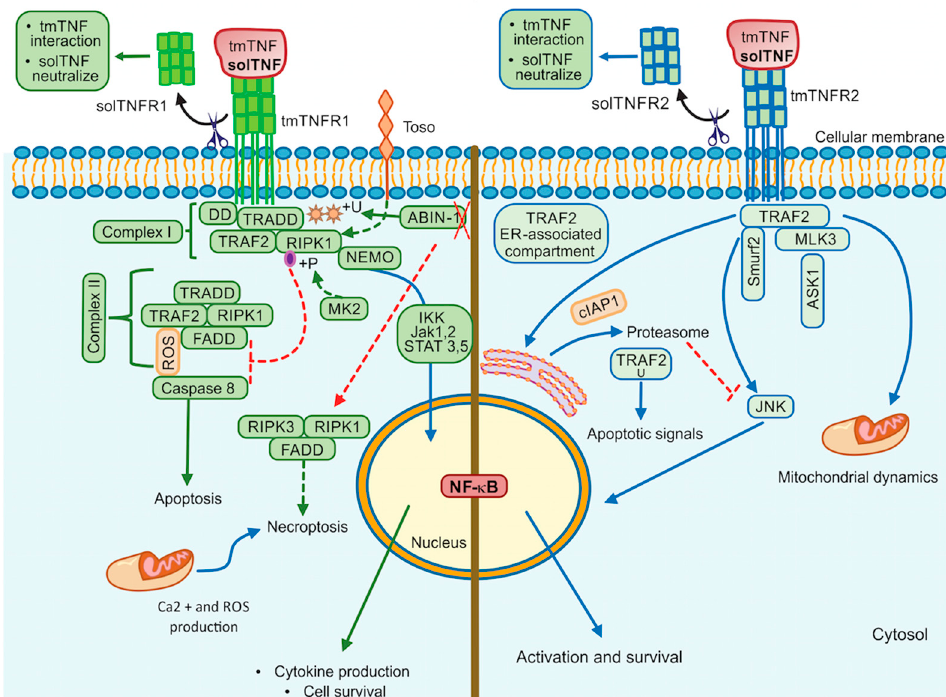
Figure 2. TNFR1 and TNFR2 activation pathways. TNFR1 signalling is involved in cell death events and inflammatory processes by classical NF-kB, whereas TNRF2 triggers signalling that may activate classical or non-classical NF-kB pathway. Additionally, TNFR2 impacts mitochondrial